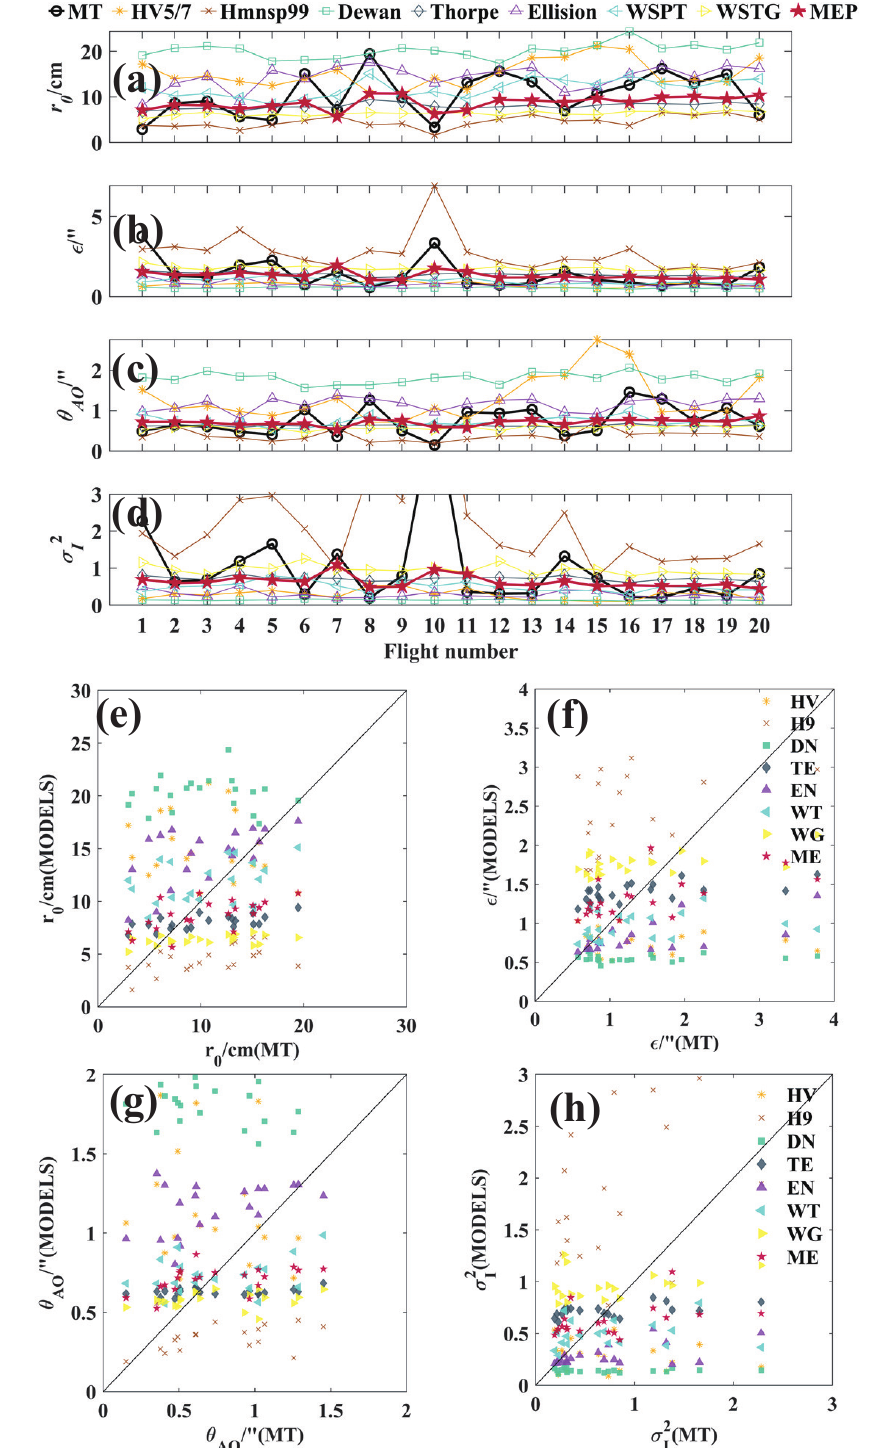
Figure 8. NCACN integrated astronomical parameters (@ λ = 550 nm). ( a ) Fried parameter r 0 ; ( b ) seeing (cid:101) ; ( c ) isoplanatic angle θ AO ; ( d ) scintillation rate σ 2